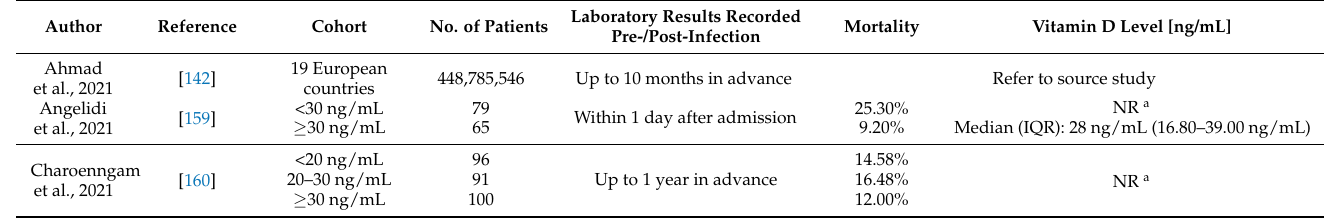
Table 2. Eligible